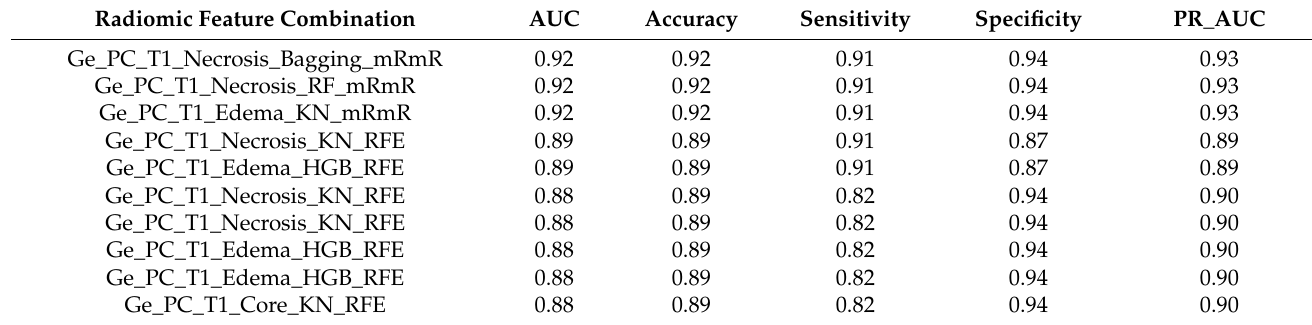
Table 3. Best 10 performances of multi-segmentation approaches, multi-machine learning classifiers, and multi-feature selection algorithms in discriminating IDH-mutant grade 4 astrocytomas from IDH-wild-type GBMs using generated (Ge) data with 50% training set.